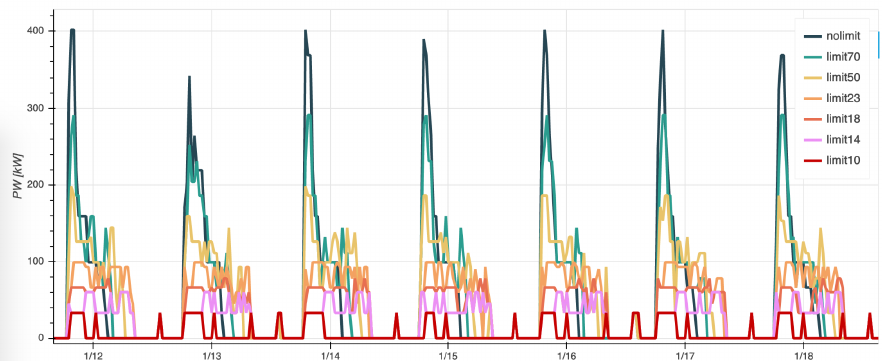
Figure 10. One week of global charging profiles. The power limits depicted are 100% (i.e., no limit, blue line), 70% (cyan line), 50% (green line), 23% (yellow line), 18% (yellow orange line), 14% (orange line) and 10% (red